Question: According to this chart, does the measure grow or shrink?
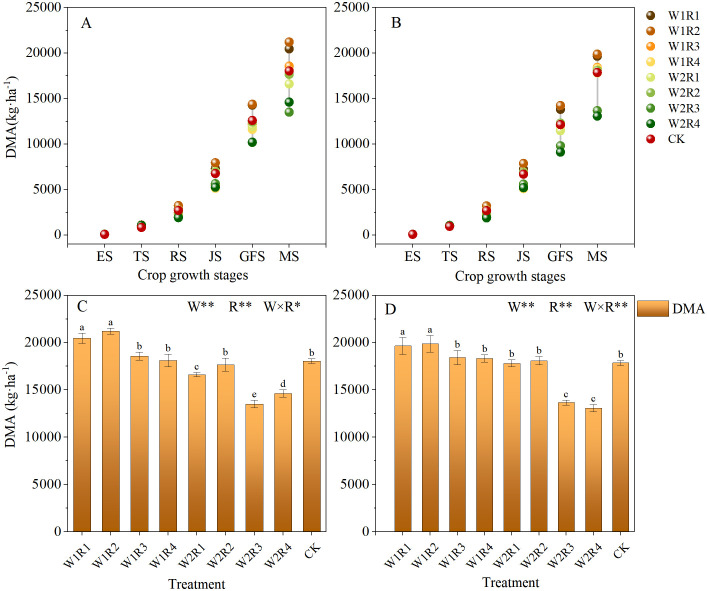
Answer: increasing